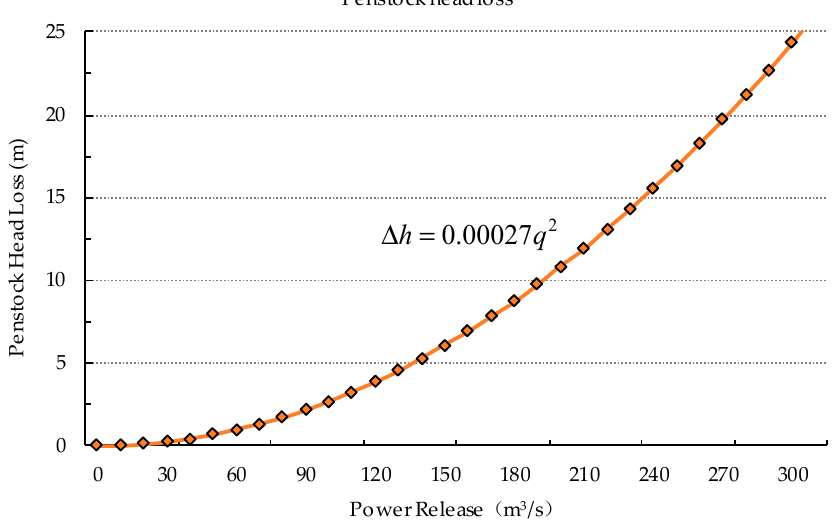
Figure 5. Relationship curve of penstock head loss for Tianshengqiao-II reservoir (TSQII). Table 2. Units’ characteristics of TSQII.